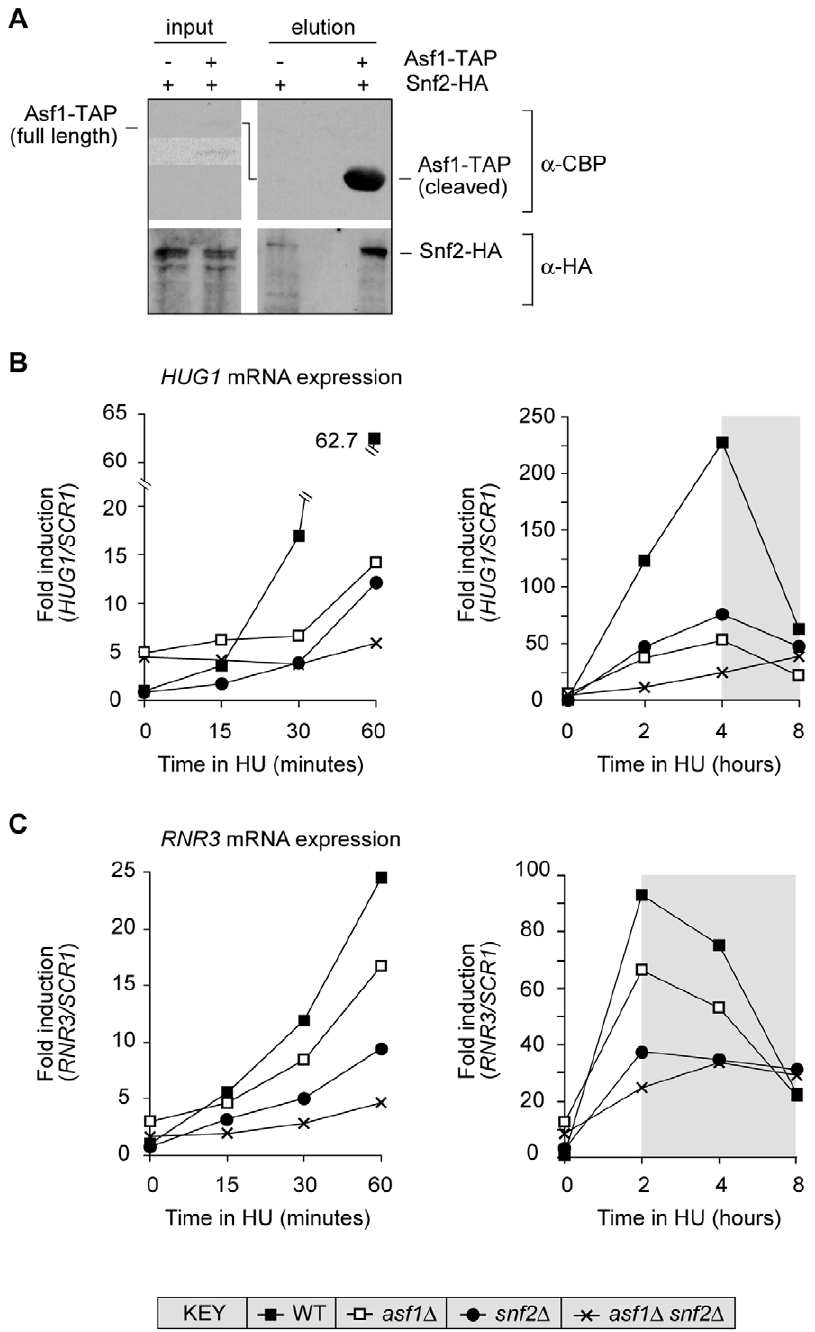
Figure 1. Asf1 and SWI/SNF: physical interaction and regulation of DDR gene transcription. A. Snf2 copurifies with Asf1. Asf1-TAP Snf2- HA and Snf2-HA lysates were used for tandem affinity purification. Inputs were obtained before binding to the first affinity column. Final eluates were resolved by SDS-PAGE and probed with either anti-CBP (top) or anti-HA (bottom) antibodies to detect Asf1 or Snf2, respectively. The high-contrast insert in the upper input panel has been included to more clearly show the presence of Asf1-TAP in the Asf1-TAP Snf2-HA lysate. B, C. Asf1 and SWI/ SNF promote derepression of the DDR genes HUG1 (B) and RNR3 (C). Expression is normalised to SCR1 . The grey shading in the right panel of B and C indicates the time period when HUG1 and RNR3 mRNA expression declines in the presence of HU.